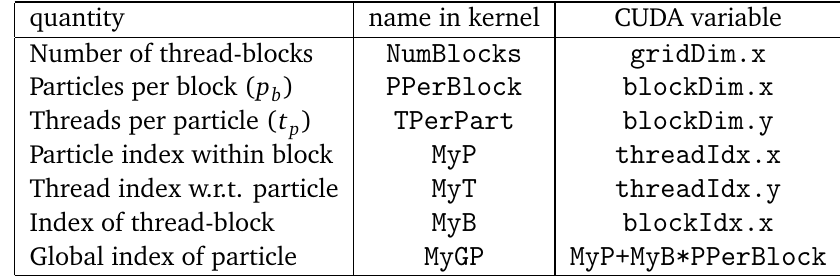
Table 1: Short-hand notation for common quantities used in